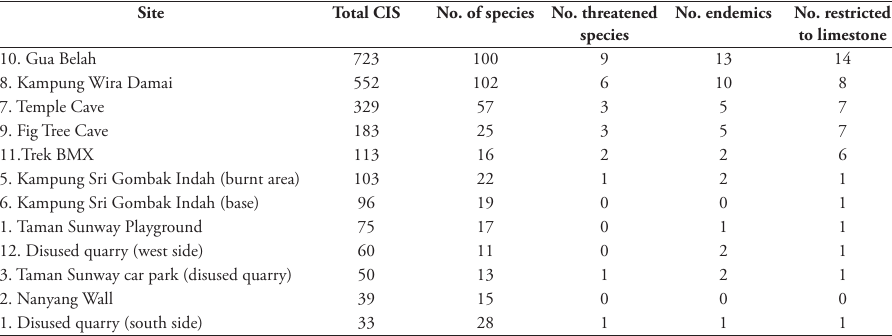
Table 9. Conservation Importance Score (CIS) for sites on Batu Caves. Site Total CIS No. of species No. threatened